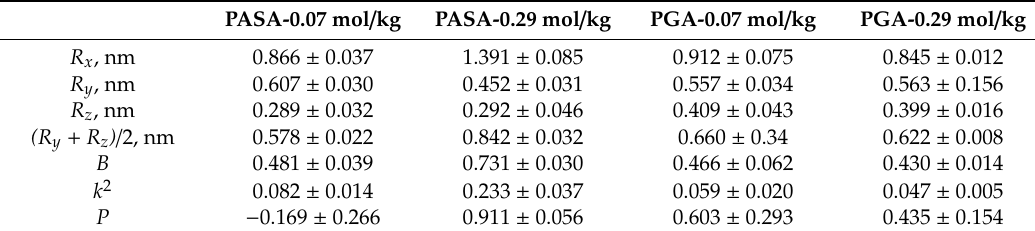
Table 3. Principle components of the radius of gyration tensor ( R x , R y , R z ). Asphericity parameter ( b ) (Equation (4)), relative shape anisotropy k 2 (Equation (5)), and prolateness ( P ) (Equation (6)) in the systems.